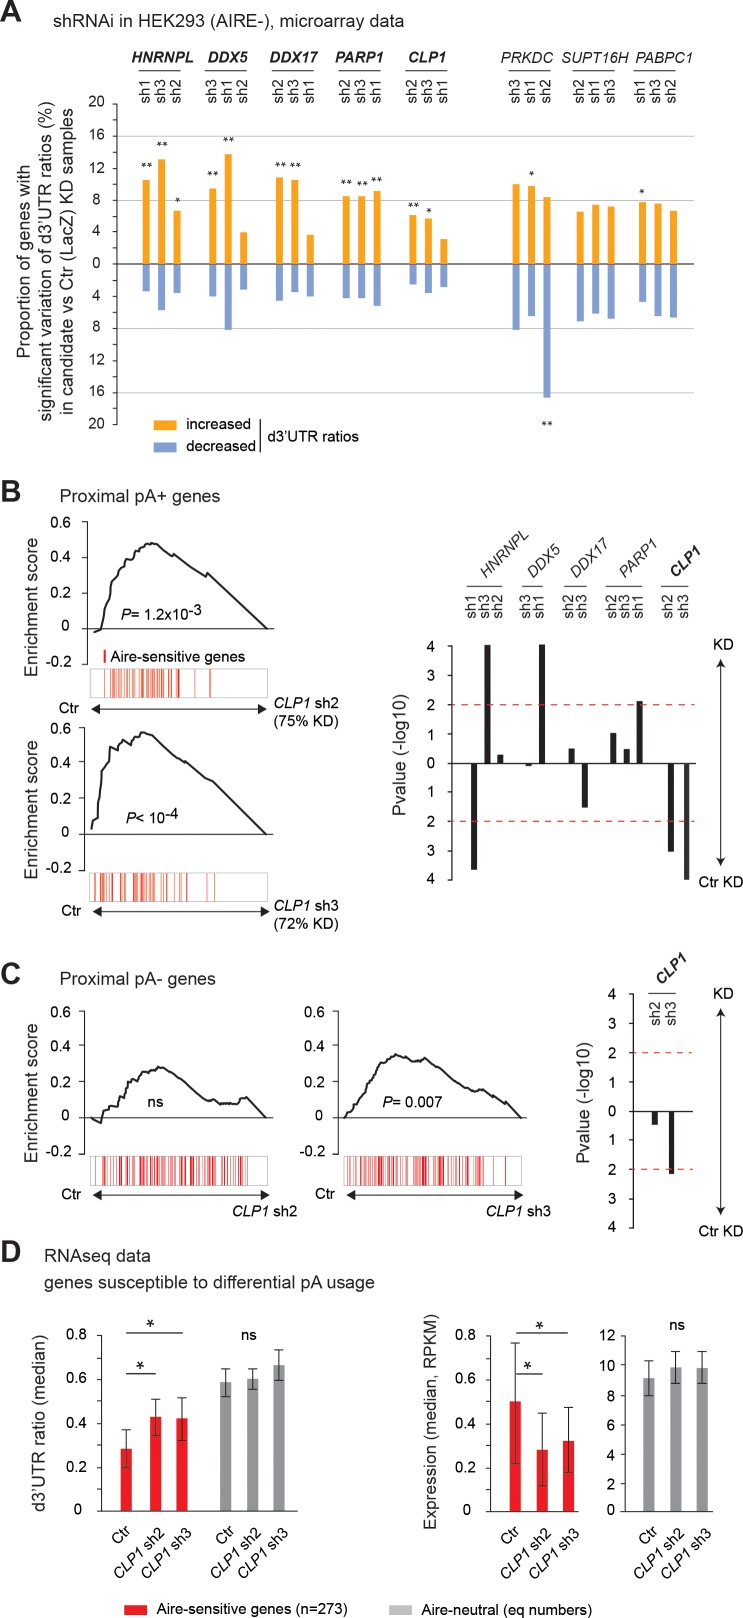
CLP1 controls the expression of Aire-sensitive genes with proximal pAs and their shortening in HEK293 cells.(A) Individual probe-level analysis of microarray data from knockdown and control HEK293 cells. Vertical bars represent the proportion of genes with a significant increase or decrease of d3’UTR ratios in the candidate vs. Ctr (LacZ) knockdown samples. *p<10−4, **p<10−9 (Chi-squared test). (B), (C) Gene Set Enrichment Analysis of Aire-sensitive genes among Ctr (LacZ) vs CLP1 KD ranked expression datasets of all genes susceptible to differential pA usage (with potential proximal pAs: proximal pA+) (B) and without potential proximal pAs (proximal pA-) (C) in their 3’UTRs as identified in the PolyA_DB 2 database. Significance and direction of the enrichment is shown for each hit shRNA, as well as P value thresholds of 0.01 by horizontal red dashed lines (Right). (D) Median of d3’UTR ratios (Left) and expression values (Right) from RNA-seq data of Aire-sensitive and neutral genes in HEK293 cells infected by lentiviruses containing CLP1 hit shRNAs or the Ctr (LacZ) shRNA; equal number (n = 273) of neutral genes included, error bars show the 95% confidence interval of the medians. *p<0.05.Figure 3—source data 1.Human Gene ST1.0 microarray probeset and individual probe expression extraction.We use the aroma.affymetrix R-package and the commands listed in the aroma.affymetrix.commands.docx file for ‘probeset expression extraction’ and ‘individual probe expression extraction’. A mandatory folder organization associated with this package is needed for the analysis. The sample CEL files must be added in a dedicated folder. (HuGene-1_0 st-v1,r3.cdf) is the Chip Description File. (probeset.csv) is the list of probeset IDs corresponding to the genes on the array. (HuGeneST1features.csv) is the list of probeset IDs and their individual probe IDs.Figure 3—source data 2.Microarray individual probe d3’UTR mapping and d3’UTR ratio calculation.Microarray_d3UTR_hg19.R: R-script to perform individual probe d3’UTR mapping and d3’UTR ratio calculation. Dependent files: - annotation file including 3d’UTR features for microarray analysis (Figure 1—source data 1): features_hg19_UTR_d.csv - Individual probe location on hg19: HuGene-1_0 st-v1.hg19.probe.csv - Individual probe expression obtained from the comparison: CTR versus CLP1 sh2 KD samples (Figure 3—source data 1): ST1features_CTR_v_CLP1_SH2.csv Result file: global_HuGene_CTR_v_CLP1_SH2.csv In the result file, the feat_WTnorm and feat_KOnorm columns correspond, for the 3UTRd features, to the d3’UTR ratios in WT and KO samples, respectively.Figure 3—source data 3.d3’UTR ratio imbalance obtained from microarray data.Microarray_d3UTR_significance.R: R-script used to perform the analysis. (global_HuGene_CTR_v_CLP1_SH2_3dUTR.csv) corresponds to global_HuGene_CTR_v_CLP1_SH2.csv that was obtained from Figure 3—source data 2 and restricted to the d3’UTR features.